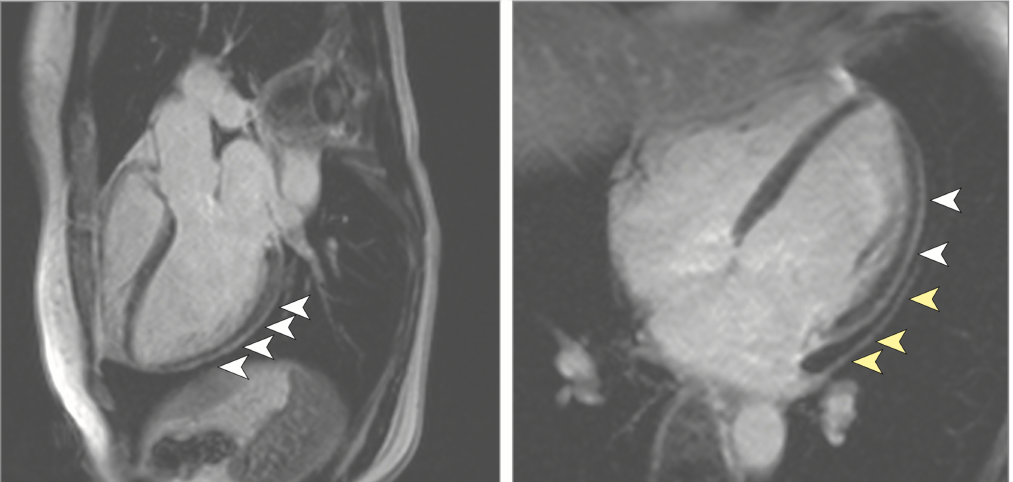
Figure 3. Pericardial effusion and enhancement (yellow arrowheads on the right image) and epicardial and intramyocardial enhancement (white arrowheads) in COVID-19, using late gadolinium enhancement [55].